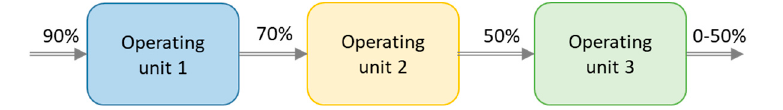
Figure 7. Schematic graph over the operating units (OU) connected in serial and the relative humidity (RH) of the inlets/outlets.